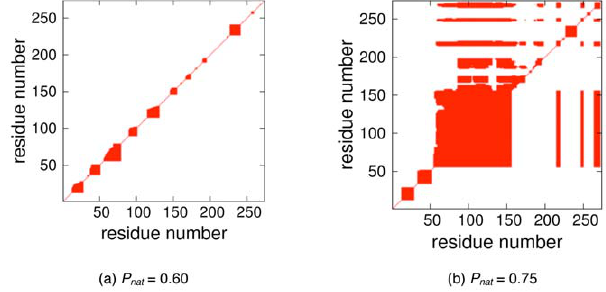
Figure 6. Rigid cluster maps (RCM) of chemotaxis receptor methyltransferase CheR structure is plotted at two different P nat values. Red coloring identifies residue pairs that are co-rigid. PG results are presented in the upper triangle, whereas the VPG is presented in the lower. At P nat ~ 0 : 60 , the protein is mostly flexible due to a lack of crosslinking H-bonds. However, the structure becomes increasingly rigid as H-bonds are added to the network. At P nat ~ 0 : 75 , the VPG slightly under-predicts the extent of rigidity. For this protein P RM ~ 0 : 80 .